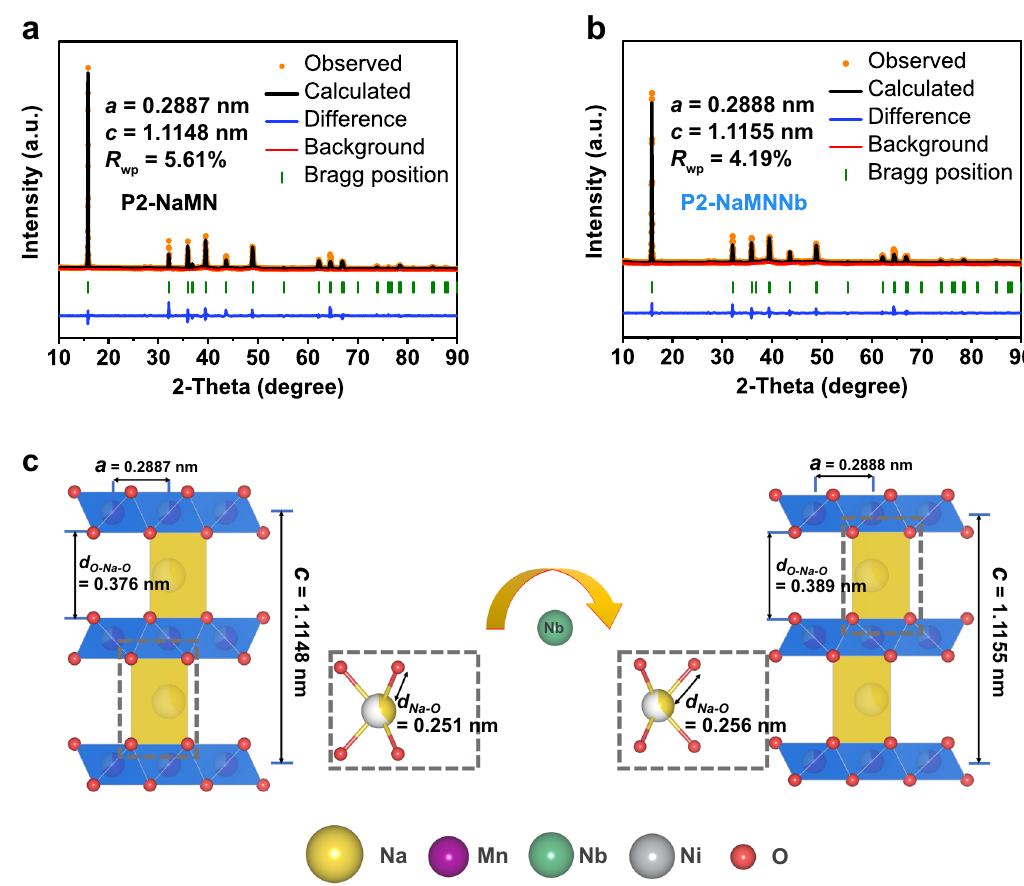
Fig. 1 Structural characterization of the P2-NaMNNb and P2-NaMN cathode material. a , b Rietveld re fi nements of X-ray diffraction measurements of P2- NaMN and P2-NaMNNb compounds. c Schematic diagram of the effect of Nb doping on crystal